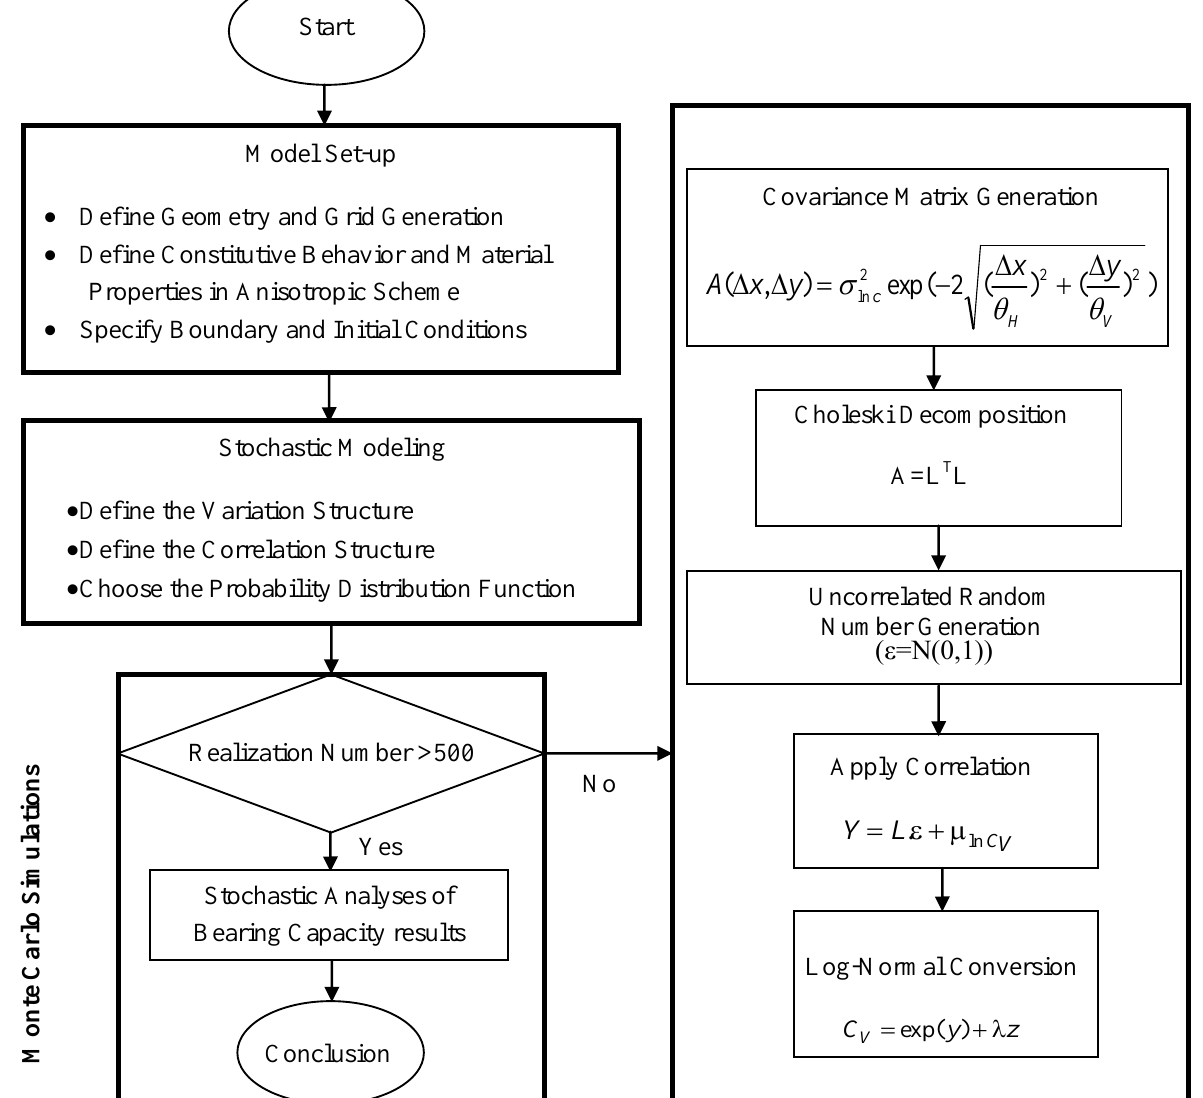
Fig. 2. Flowchart for Monte Carlo simulation adopted in current